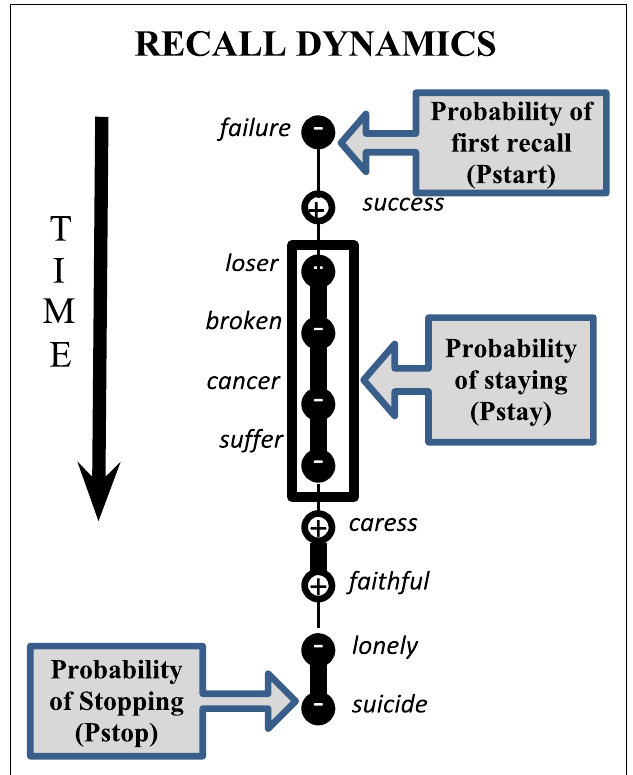
FIGURE 1 | Schematic overview of recall dynamics. Words are consecutively recalled are displayed vertically. Negatively valenced words are marked by a black sphere with a “ − ”, while positively valenced words are marked with a “ + ”.The vertical lines between valence signs indicates the strength of the association (i.e., heavier lines denote stronger